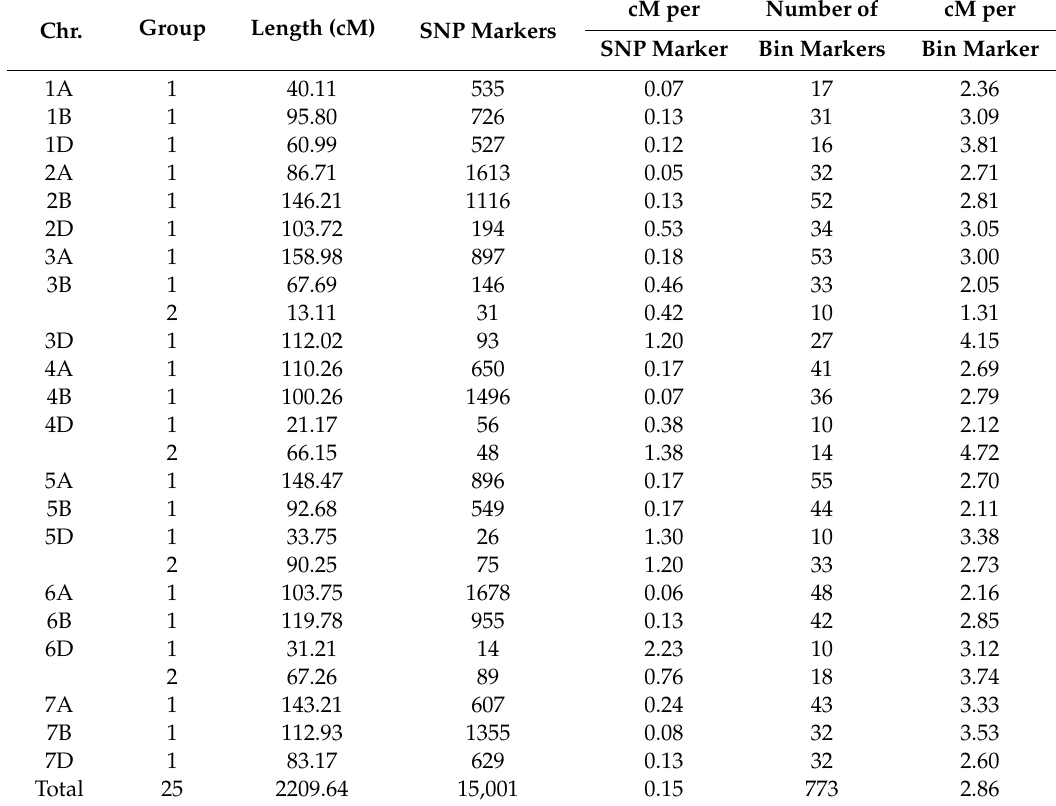
Table1. Distributionofthemappedmarkersinthegeneticmap. SNP:single-nucleotidepolymorphisms.